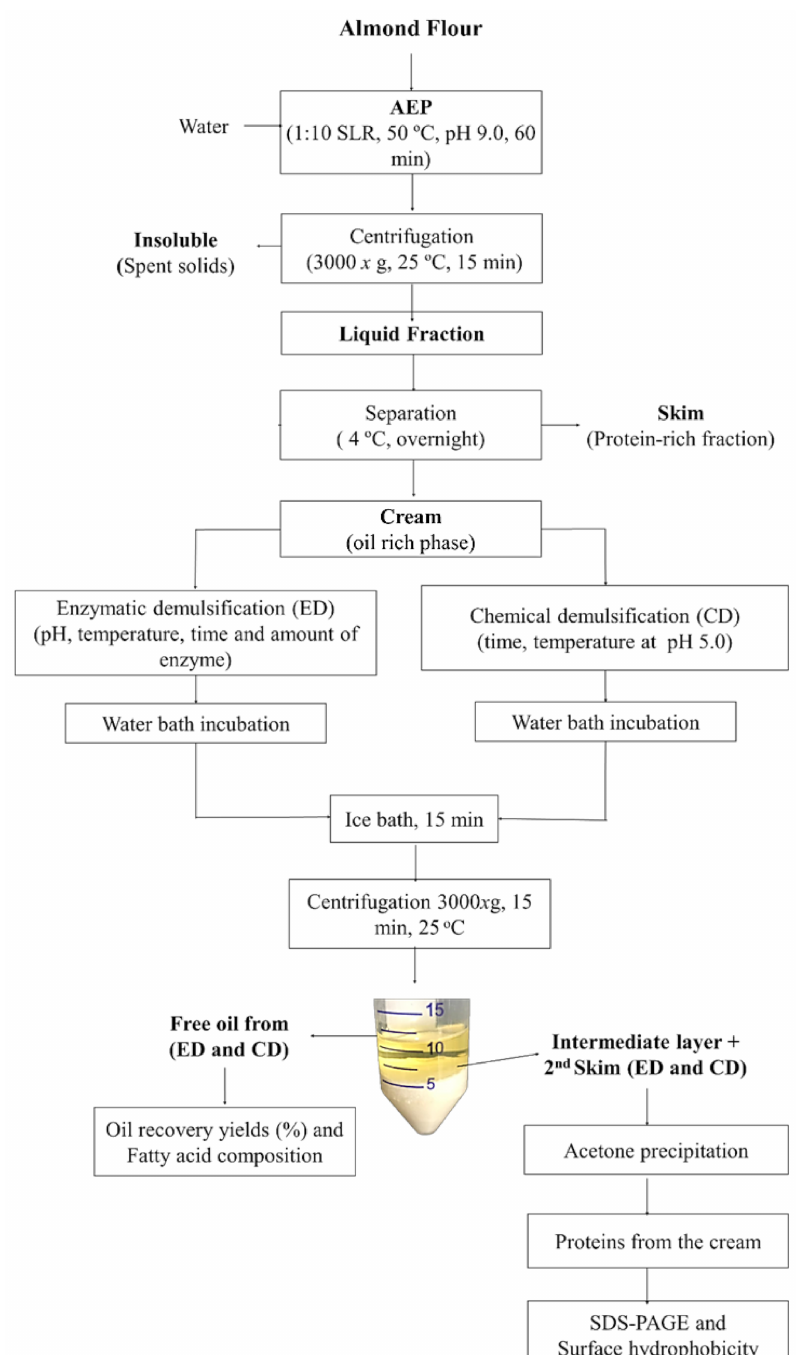
Figure 1. Process flow diagram for the aqueous extraction process (AEP) of almond flour and demulsification (ED: enzymatic demulsification and CD: chemical demulsification) strategies to recover the oil from the cream emulsion. SLR, solids-to-liquid ratio; SDS-PAGE, sodium dodecyl sulfate-polyacrylamide gel